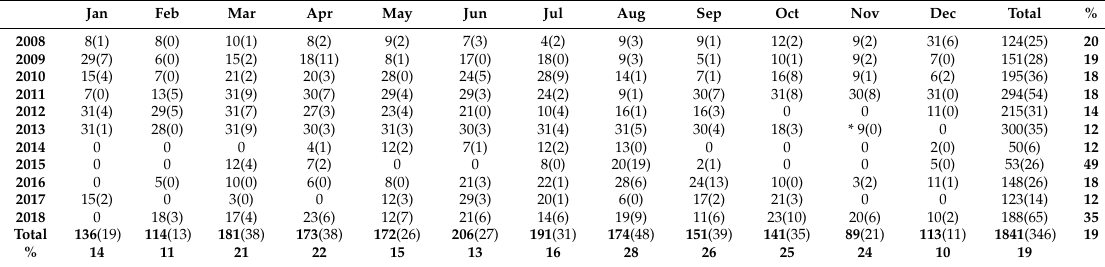
Table 3. The number of lidar / ceilometer-derived diurnal cycles of the atmospheric boundary layer over Warsaw, for the years 2008 to 2018. The number of the available clear-sky cycles is given in brackets. The percentage of clear-sky data to the total number of observations is indicated for each year and each month. Note that before 31 October 2013, the ceilometer data were used, and after that date, the lidar data were used (denoted with